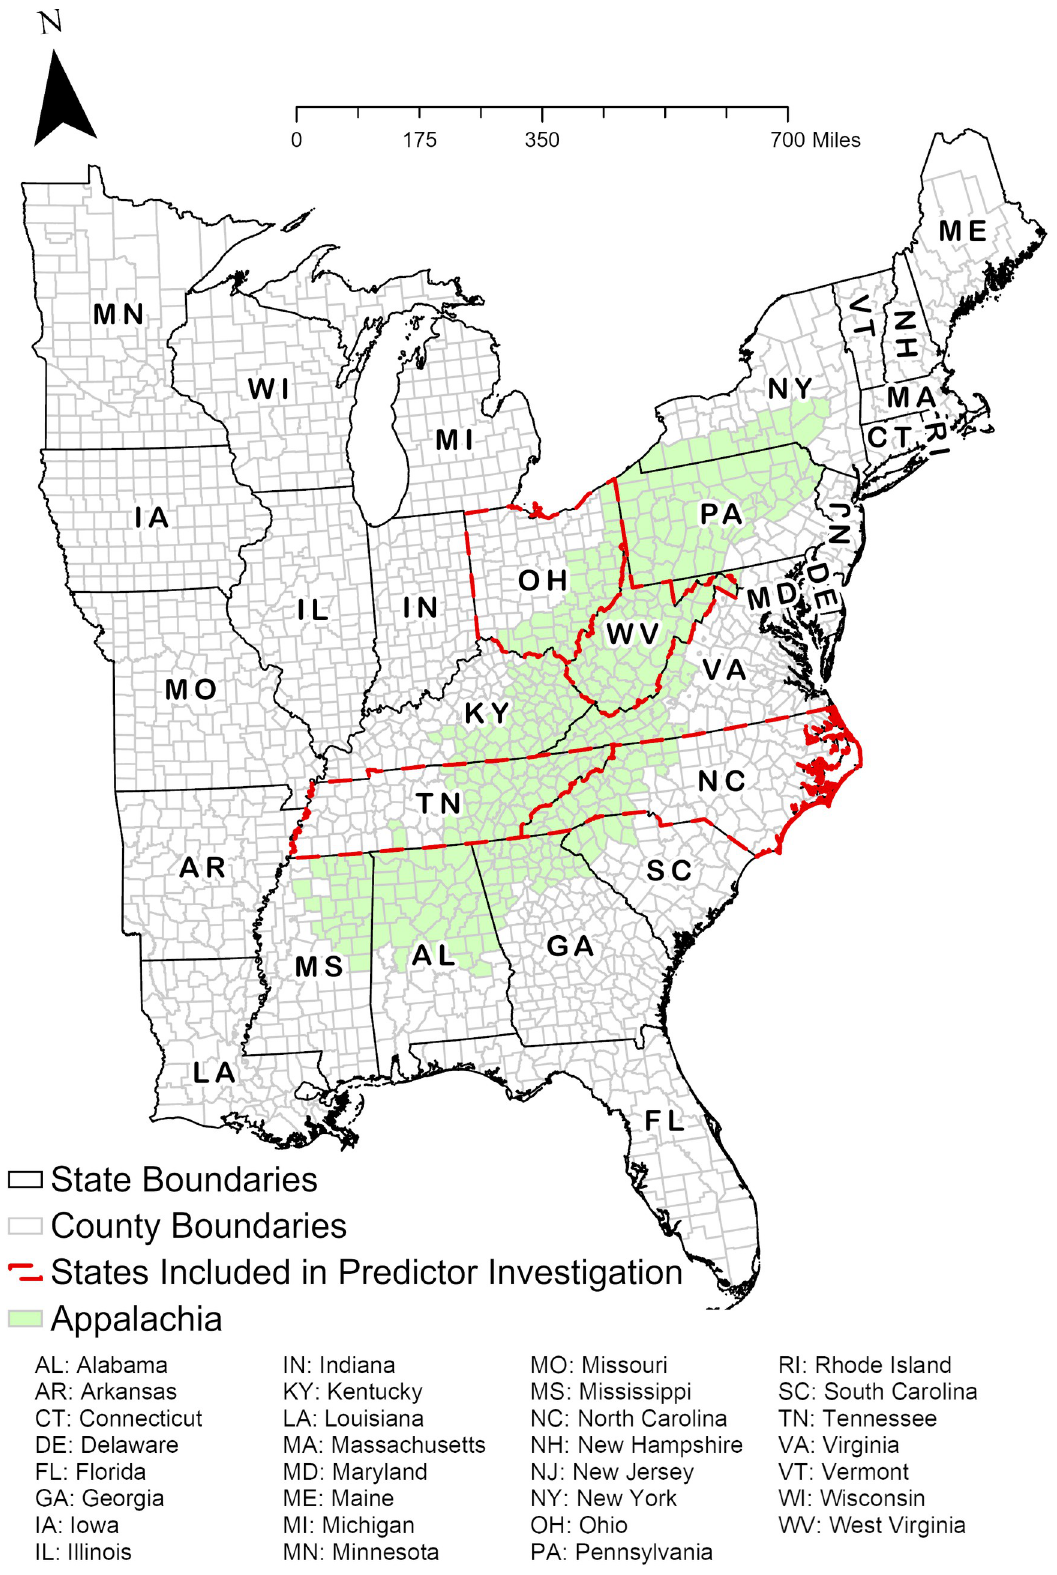
Fig 1. Map of the study area (eastern United States) with state boundaries, county boundaries, boundaries of states used for investigation of risk predictors, and state abbreviations.